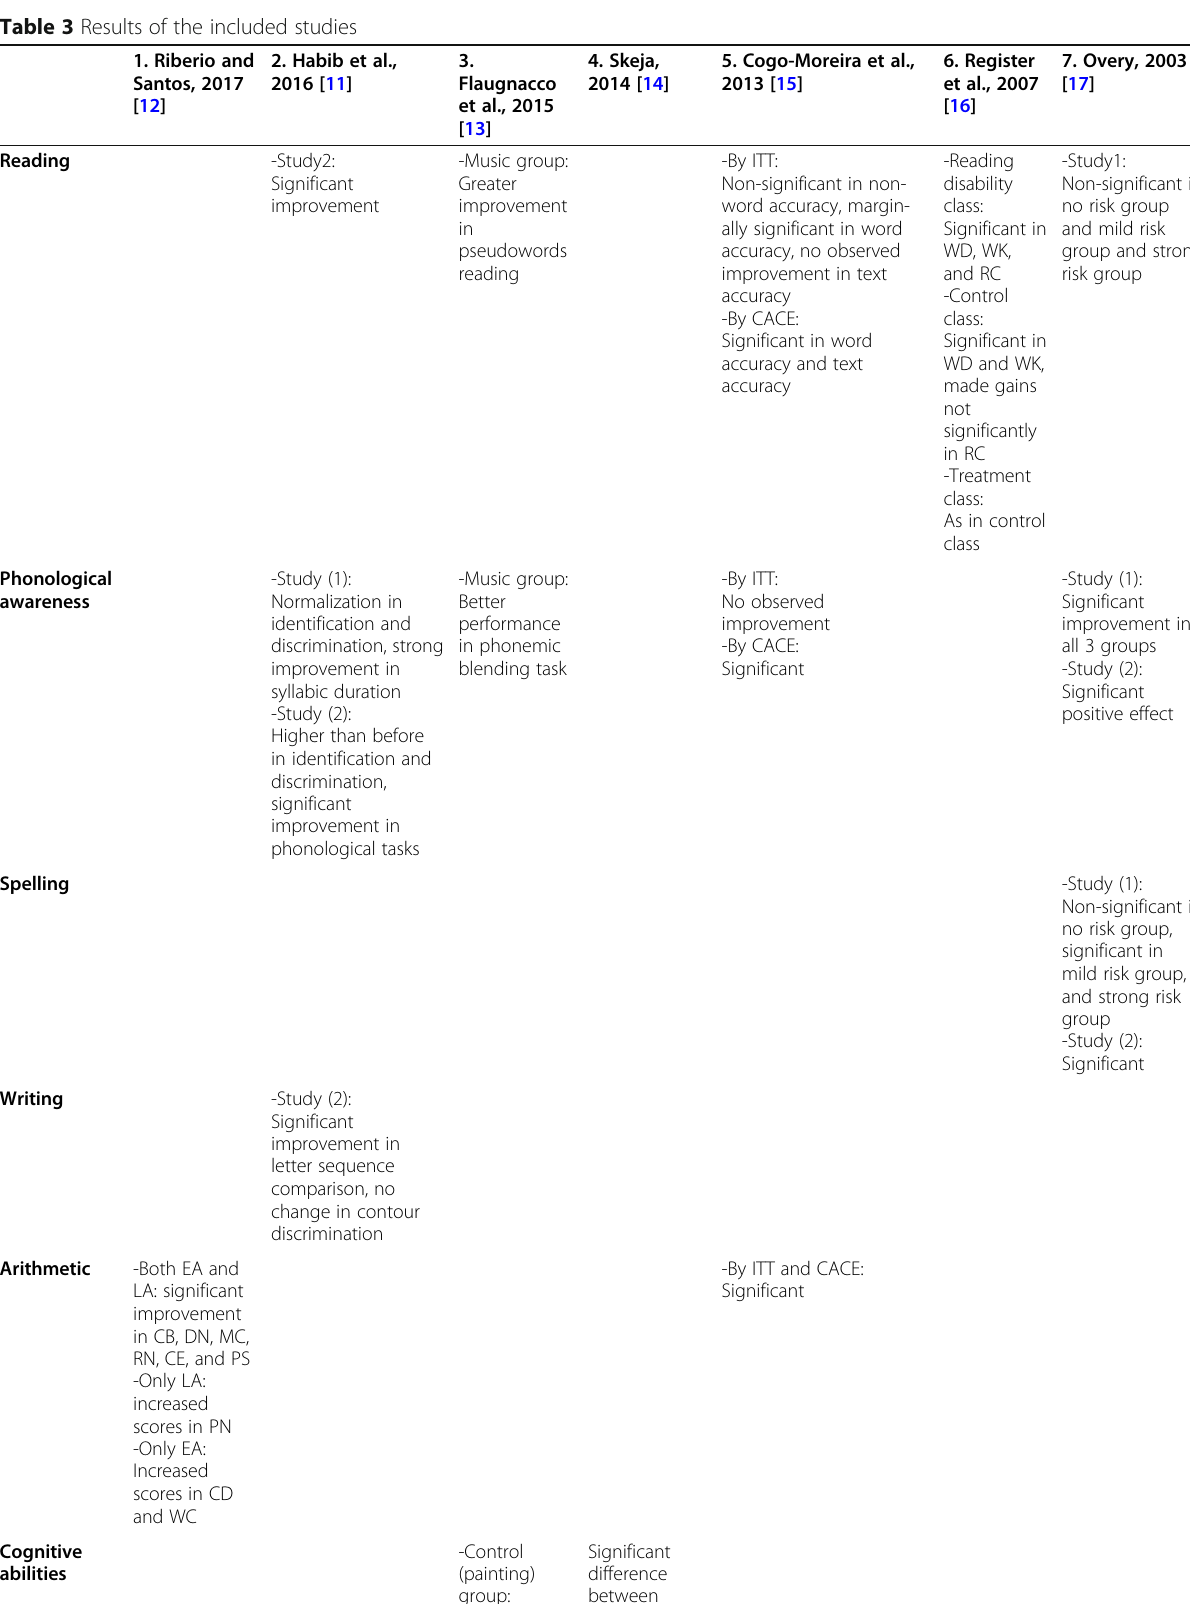
Table 3 Results of the included